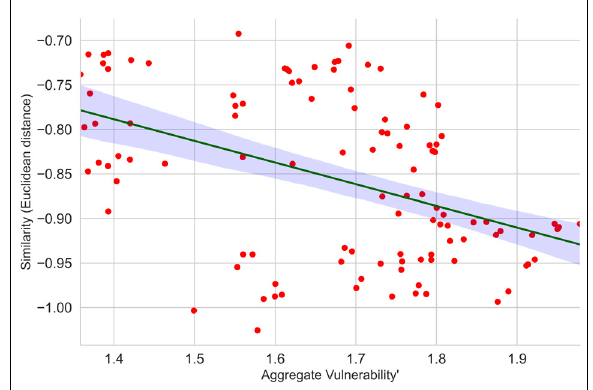
Figure 7: Scatter plot of average portfolio similarity of the largest 10 banks as measured by the Euclidean distance and aggregate banking sector vulnerability to spillover losses.